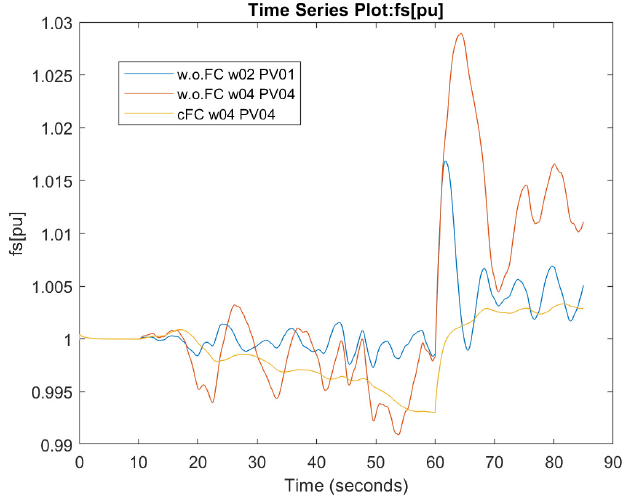
Figure 26. Simulation 7 for different scenarios frequency trend.